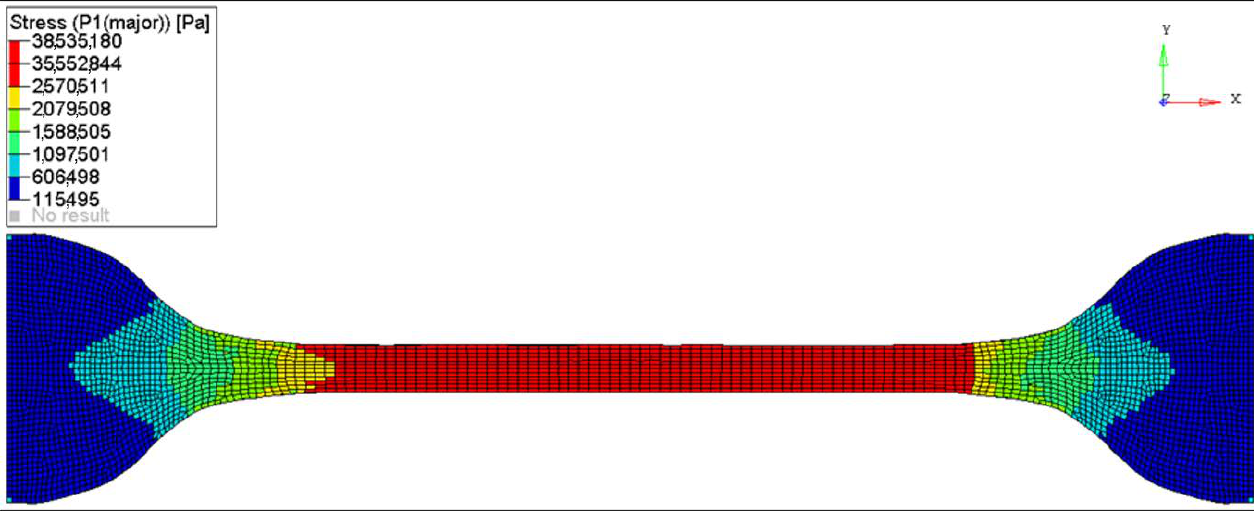
Figure 4. PVB tensile test — FEM at t = − 30 °C.